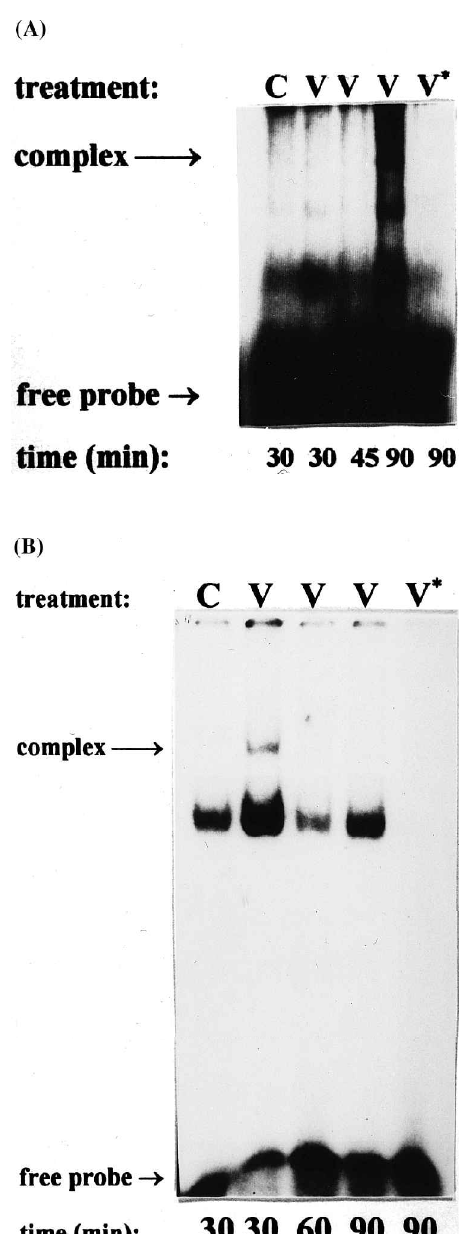
FIG. 5. Vaccinia virus inducible NF- k B binding activity in U937 and HUVEC. Double-stranded oligonucleotide comprising NF- k B site was incubated with nuclear extracts isolated from control (C) and vaccinia virus (V) infected U937 cells (MOI 1:1) (A) or HUVEC (MOI 2:1) (B). V*–100-fold excess of unlabelled dsDNA oligonucleotide added as a competitor. Specific complexes and free probes are